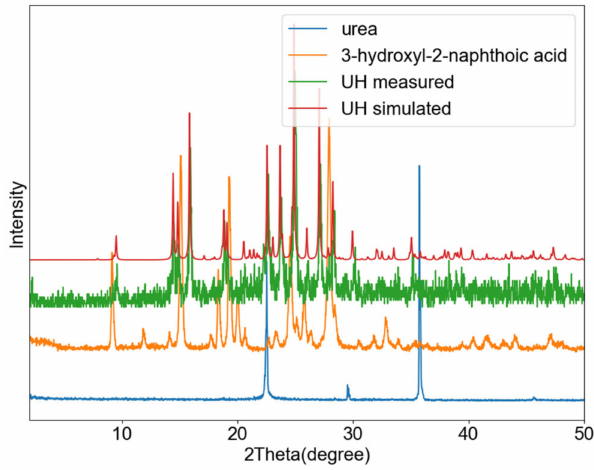
Figure 6. PXRD profiles of urea ( blue ), UH co-crystal obtained by grinding ( green ), the simulated UH pattern ( red ) and the experimental 3-hydroxyl-2-naphthoic acid pattern ( orange ). Further, 3-hydroxyl-2-naphthoic acid shows a single melting point with onset at 218 ◦ C and an associated 173.3 J/g heat of fusion. The cocrystal in turn shows a single melting temperature at 155 ◦ C with a heat of fusion 156.78 J/g followed by immediate degradation. As common for cocrystals, this melting point lies between that of both parent compounds. TGA confirms degradation upon melting for all phases (Figure 7).